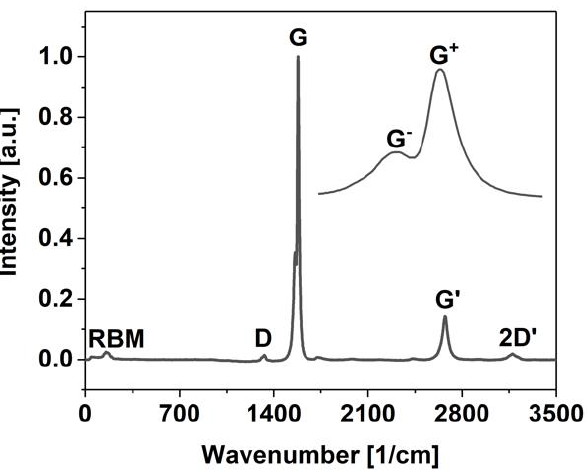
Figure 2. Raman spectrum of the SWCNT parent material utilized to make the free-standing films in this study. Splitting of the G band into G − and G + components is visualized in the inset.